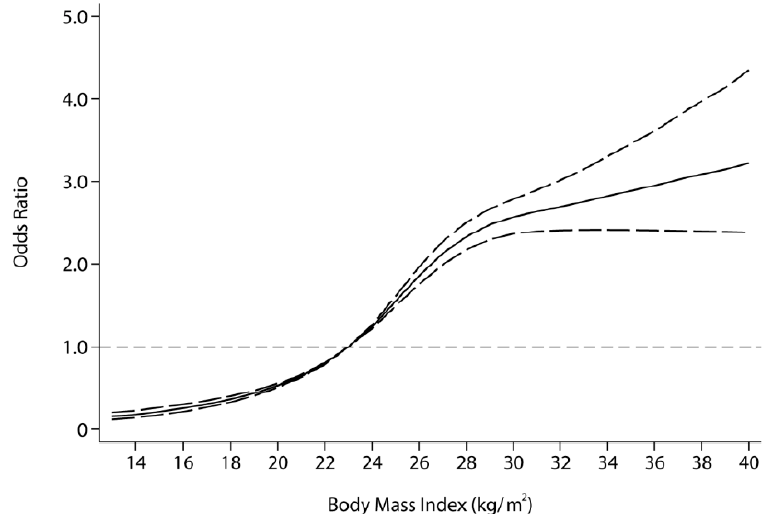
Figure 1. The dose-response relationship of BMI and hyperlipidemia based on the restricted cubic spline model (BMI was coded using an RCS function with four knots located at the 17.71 kg/m 2 , 22.50 kg/m 2 , 26.83 kg/m 2 and 31.52 kg/m 2 , which respectively correspond to four sections of the median BMI. Lines with long dashes represent the pointwise 95% confidence intervals, comparing for solid lines representing the fitted nonlinear trend).